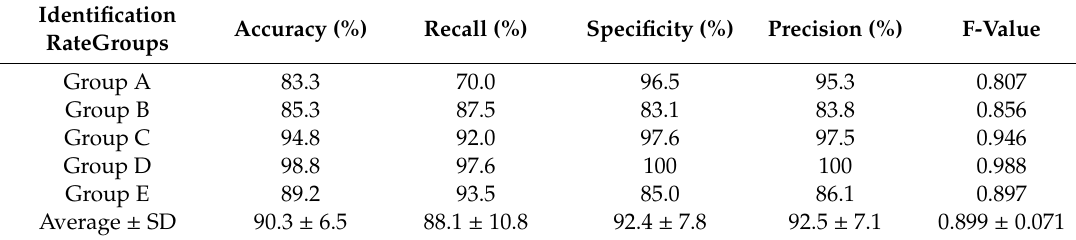
Table 6. Identification rate of the neural network based on OD image